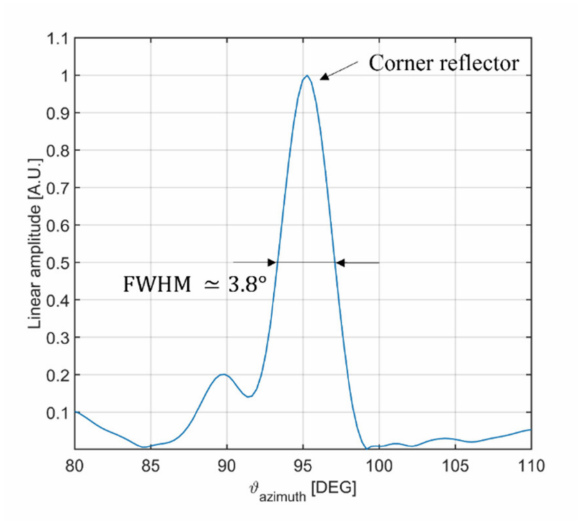
Figure 11. Point spread function in terms of